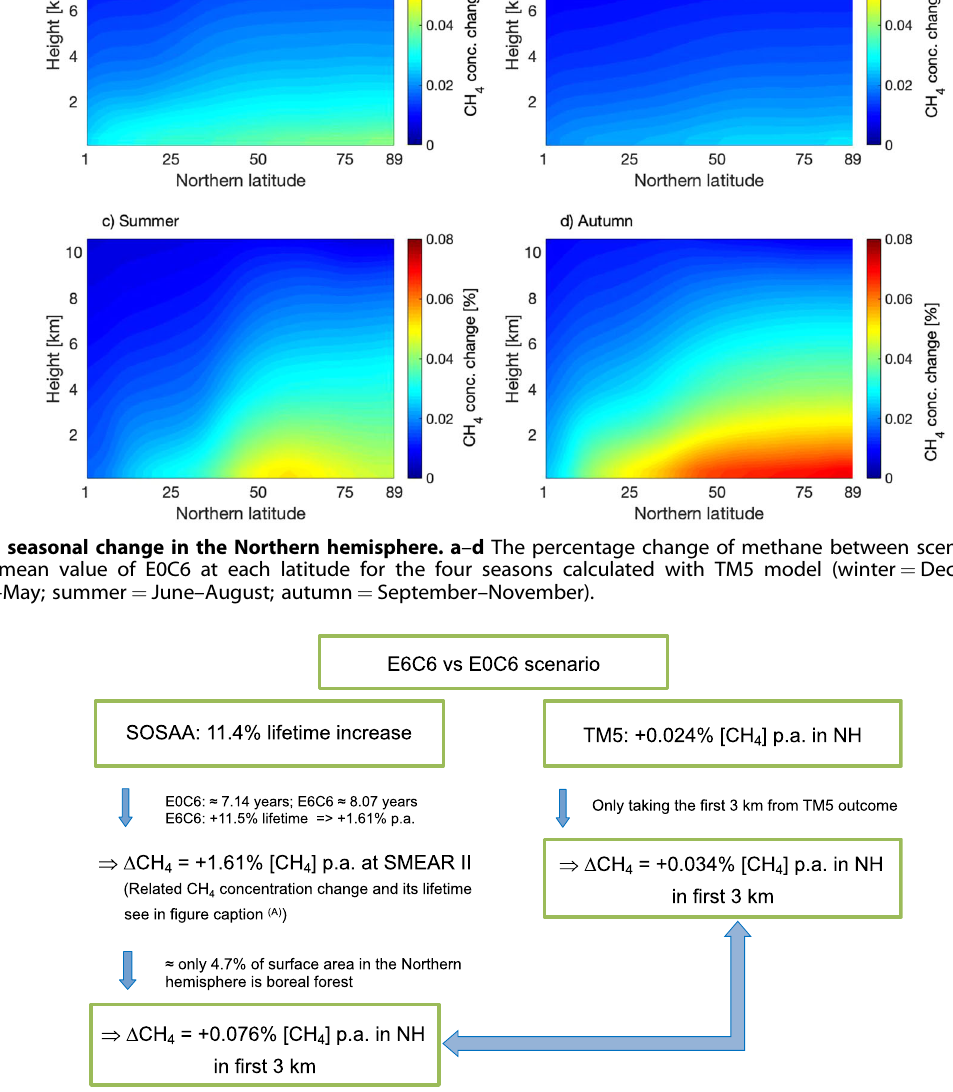
Fig. 6 SOSAA-TM5 comparison. Schematic illustration how the outcomes calculated by SOSAA and TM5 models lead to the same result concerning the methane impact when comparing E6C6 and E0C6 scenarios. (A) Theoretical proof for the relation between the methane concentration and its lifetime is provided in the supplementary